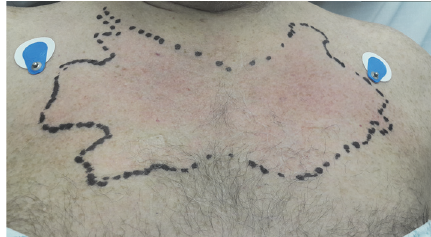
Figure 1: Erythema around bilateral sternoclavicular area in a “butterfly-like” distribution.